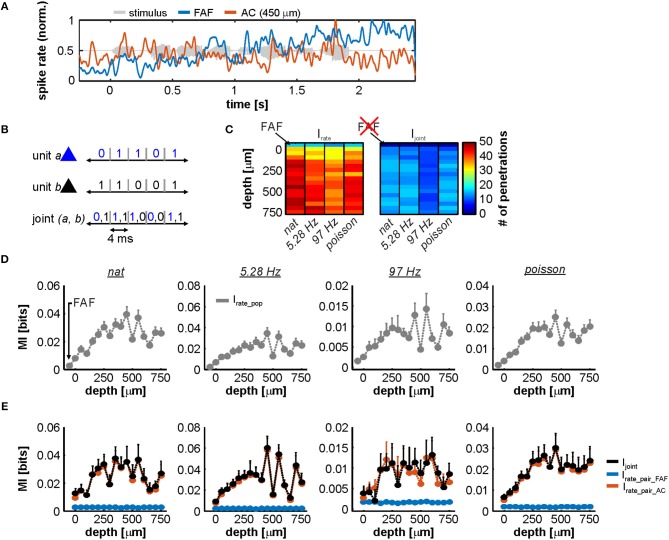
Information in rate codes of the FAF-AC circuit. (A) Spiking activity in an exemplary simultaneous recording from the FAF (blue) and the AC (at 450 μm, orange). Note the difference in the response patterns between the two structures. (B) Schematic representation of the joint code used for information theoretic calculations. (C) Number of units used to calculate Irate (left heatmap; 1 unit per penetration), for each stimulus (natural call, syllable train at 5.28 Hz, syllable train at 97 Hz, and Poisson syllable train) and depth in the AC (note that the first row in the heatmap corresponds to the FAF). Only units that had at least 0.1 bit/s of information were considered. The right heatmap depicts similar information, showing the number of pairs (FAF-AC spiking; 1 pair per penetration) used to calculate Irate per stimulus and AC depth. In this case, FAF is missing because it is already part of each a pair. (D) Population Irate in the FAF and across AC depths (note that the leftmost values correspond to the FAF), for each of the four stimuli presented (left to right). (E) Ijoint (black) shown together with Irate from AC (orange) and FAF (blue) units that conformed the pairs, across stimuli (i.e., Irate_pair_AC and Irate_pair_FAF). There were no consistent significant differences between Ijoint and Irate, when the latter was calculated for AC units (Wilcoxon signed rank tests, p > 0.05).